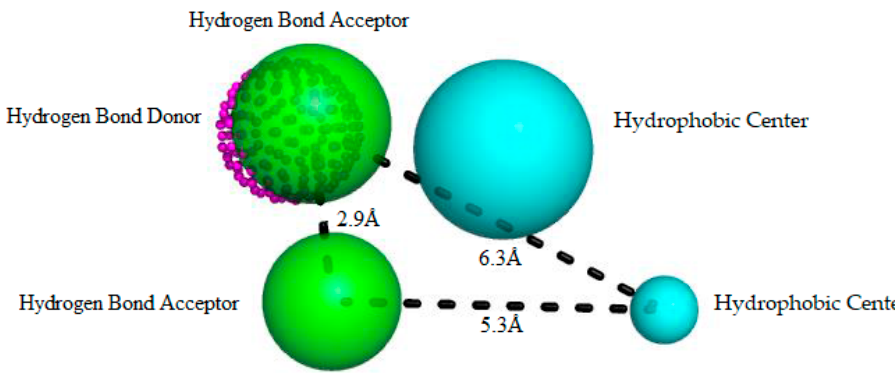
Figure 2. Best pharmacophore model here obtained for RIPK2 inhibitors. This model has two hydrophobic centers (cyan spheres), two hydrogen bond acceptors (green spheres) and a hydrogen bond donor (magenta dotted sphere). The size of the beads varies according to the tolerance radius calculated using GALAHAD. All the distances are measured in Angstroms.